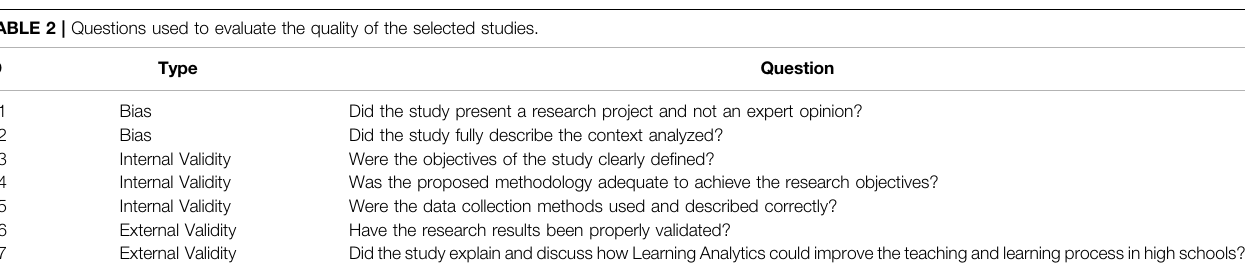
TABLE 2 | Questions used to evaluate the quality of the selected